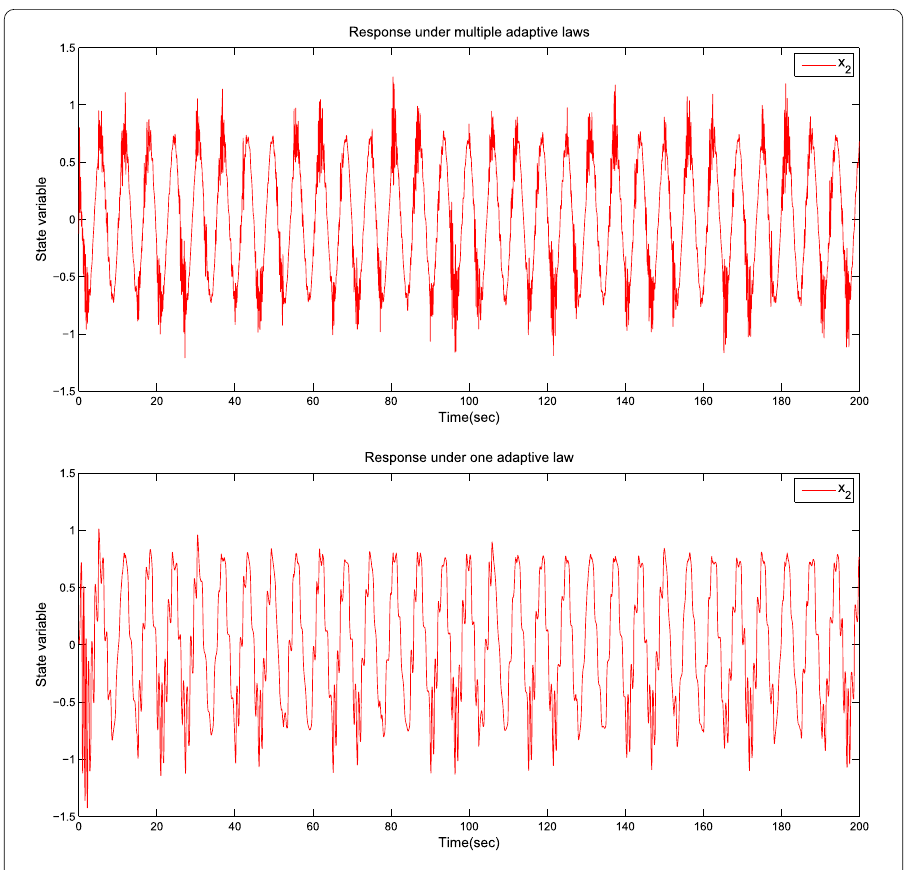
Figure 2 Responses of the state variable x 2 of Example